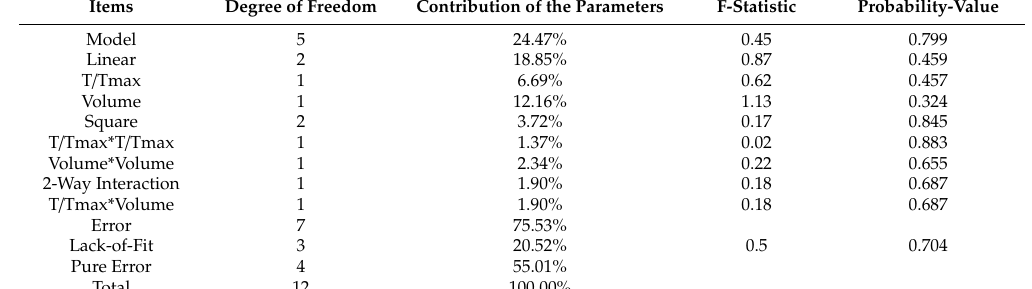
Table 7. ANOVA for specific heat.